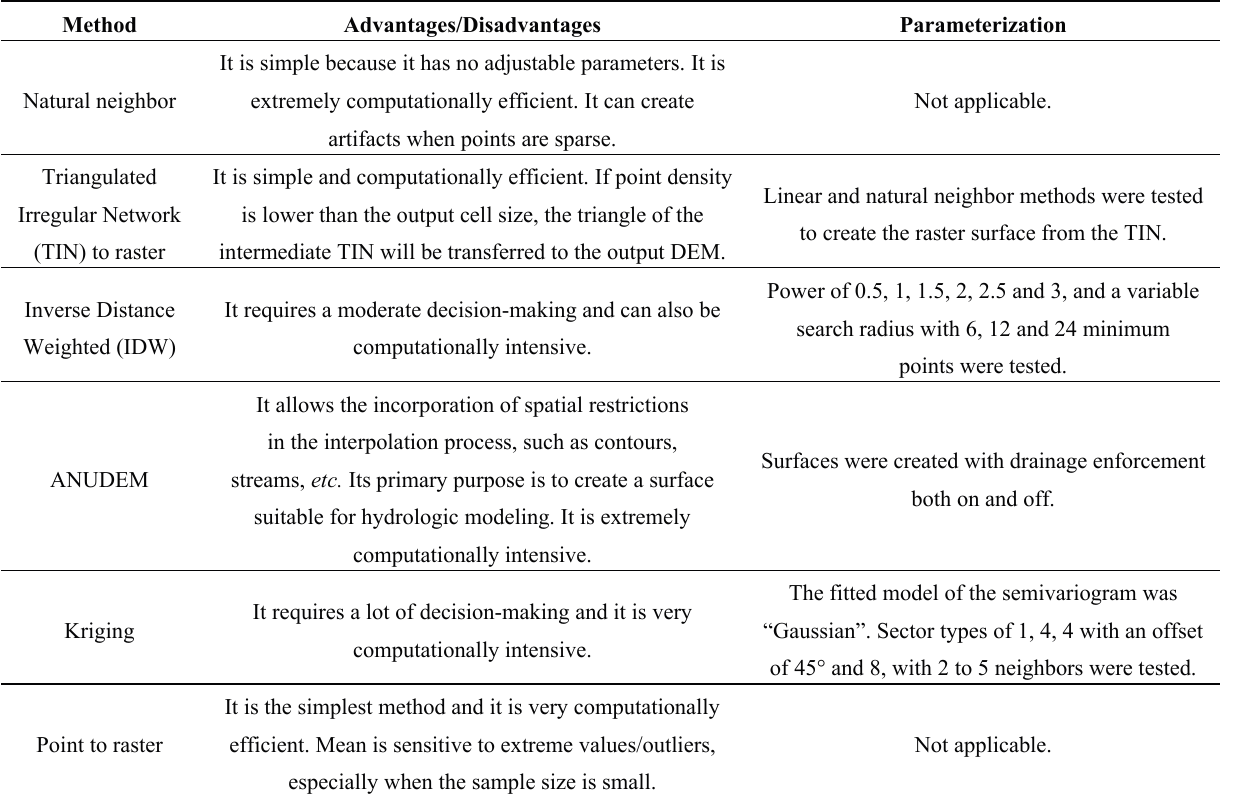
Table 2. Interpolation routines, most important advantages and disadvantages and the parameterizations tested in this